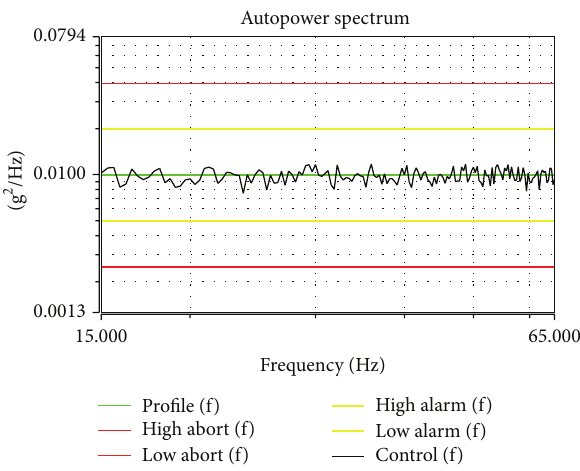
Figure 9: Vibration excitation signal under test profile B3.